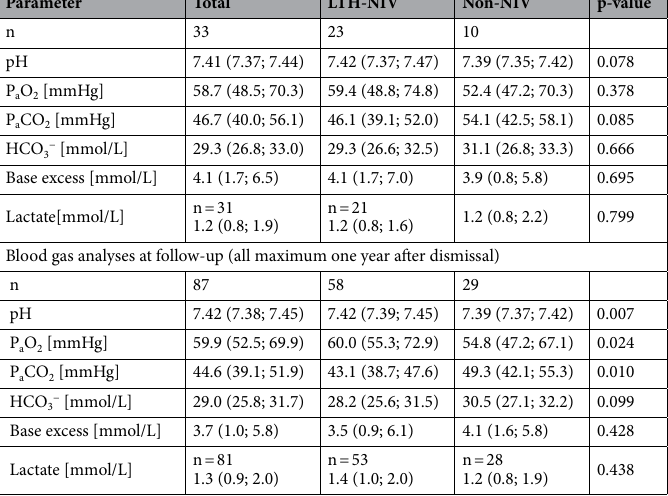
Table 3. Blood gas analyses at follow-up. PaO 2 partial pressure O 2 ; P a CO 2 partial pressure CO 2 ; HCO 3− standard bicarbonate.